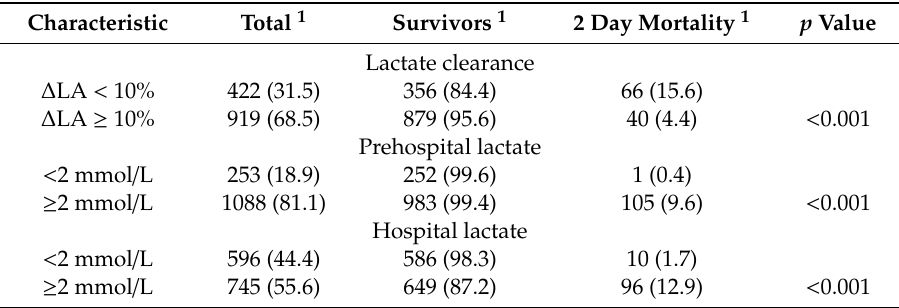
Table 2. Correlation between ∆ LA and 2 day mortality.